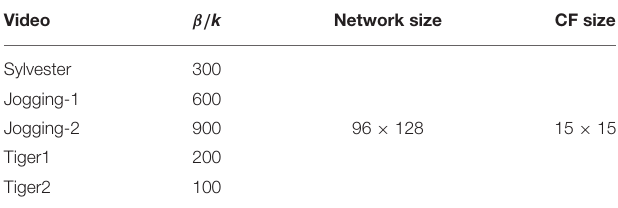
Table 3 , the sylvester video is in a simpler environment